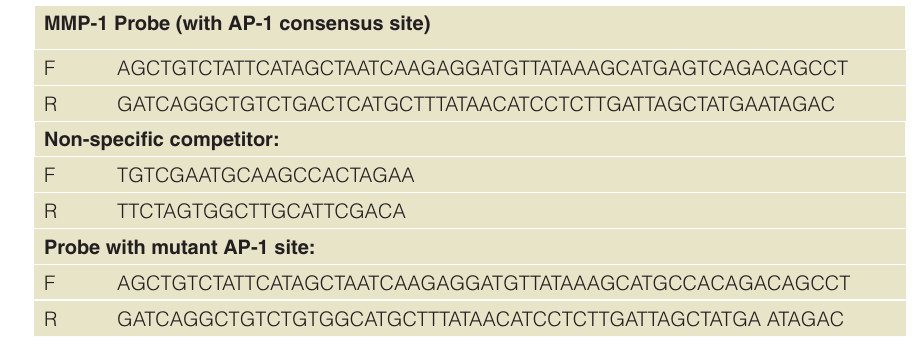
Table 4. Double stranded oligonucleotide probes used for Electrophoretic Mobility Shift Assays. The Forward and Reverse oligonucleotides were annealed for each